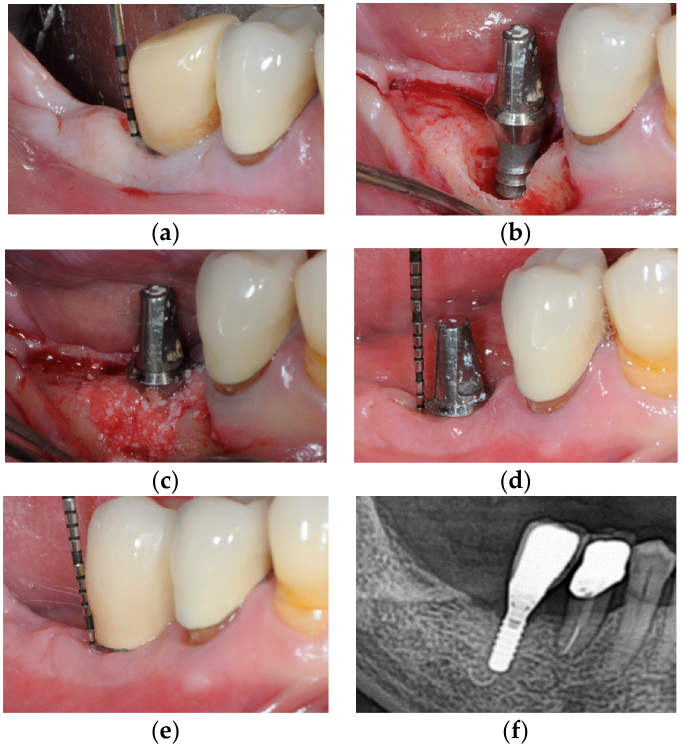
Figure 5. ( a ) Mandibular right premolar implant installed in pristine bone showing increased probing pocket depth as compared with previous records, bleeding and pus exhibiting shortly after probing; ( b ) Intra-operative appearance of the peri-implant infra-osseous defect after debridement; ( c ) Anorganic bovine bone mineral with 10% collagen is applied in the infra-osseous component; ( d ) Six-month follow-up after non-submerged healing, no signs of inflammation and peri-implant probing depth was noted to be consistent with health; ( e ) One-year follow-up after delivery of the final restoration. Note, peri-implant stability; ( f ) Radiographic image, at 1-year follow-up, reveals substantial bone fill.